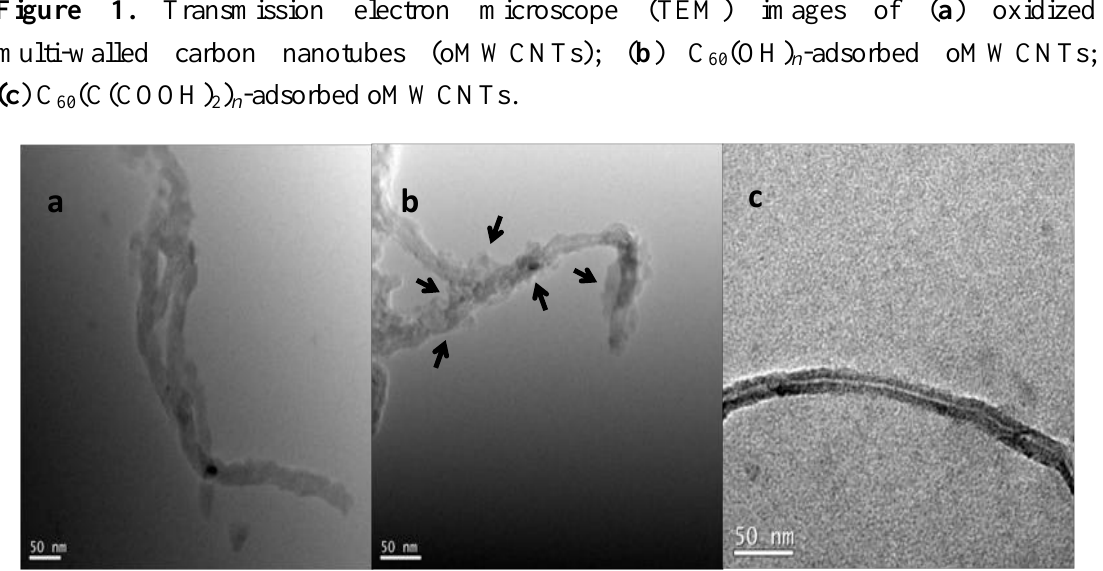
(OH) -adsorbed oMWCNTs; 60 n